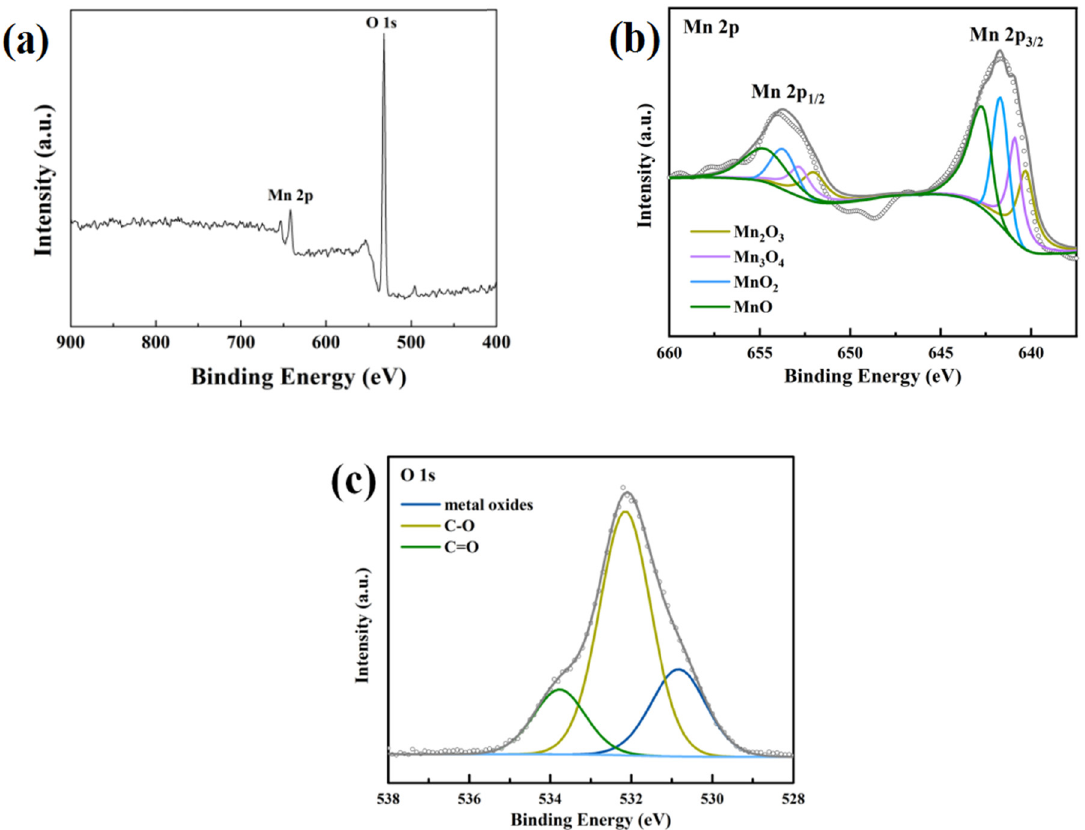
Figure 9: XPS spectra of manganese volatiles. ( a ) Survey spectra, ( b ) Mn 2p spectrum, and ( c ) O 1s